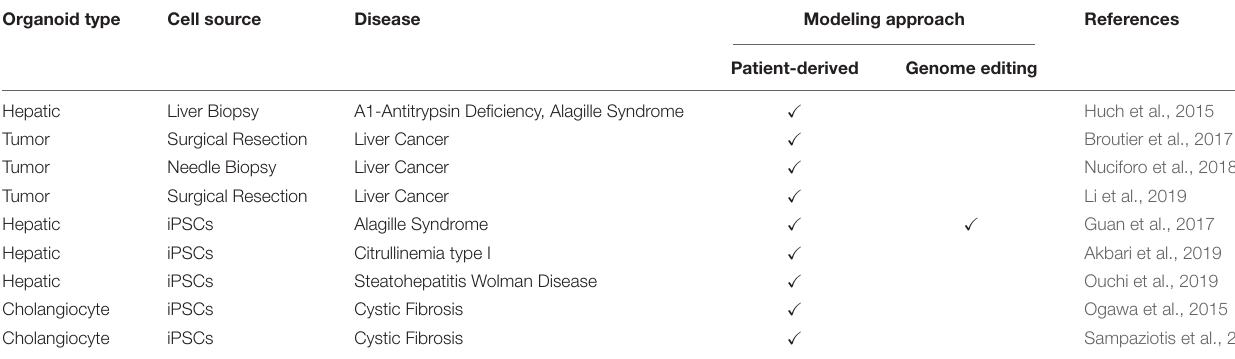
TABLE 1 | Organoid-based liver disease